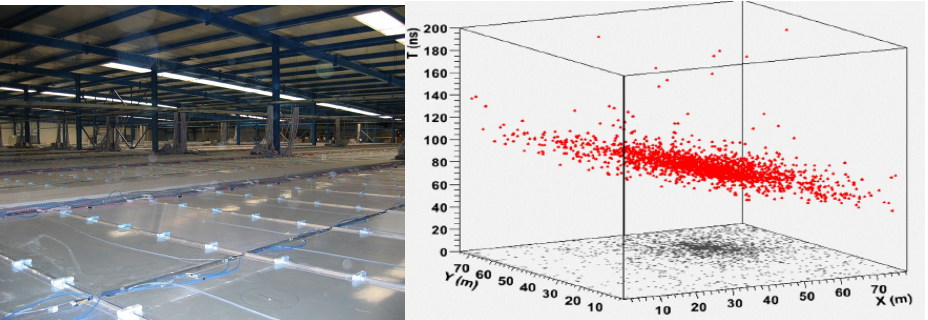
Figure 2. ARGO-YBJ detectors and an example of recoded event. In the left panel, the inside view of the ARGO-YBJ hall with RPCs deployed on the floor. Each RPC has a size of 3.3 m 2 including 10 units, each of which measures number of particles up to 8 and times the arrival of those particles with a resolution of ∼ 1 ns. In the right panel, an event recorded by the center array. The vertical axis is the timing of the particles in each unit whose location is shown in the x-y-plane of the array. With the low energy threshold, the median EAS energy for the lowest bin of